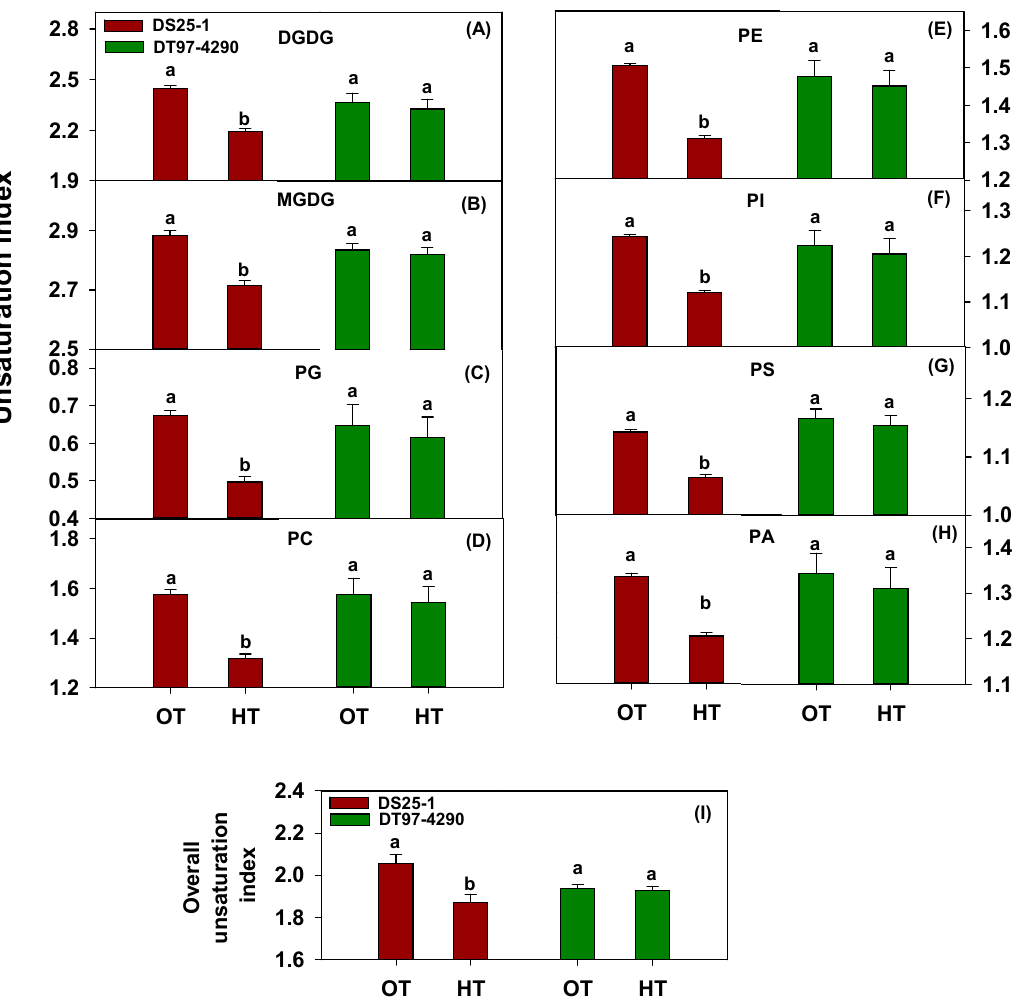
Figure 3. Decrease in unsaturation index under heat stress in the heat-tolerant soybean genotype DS25-1 and no change in unsaturation index under heat stress in the heat-susceptible genotype DT97-4290. Panels A through H show the e ff ects of temperature on unsaturation index of various lipid head group classes (DGDG, MGDG, PG, PC, PE, PI, PS, and PA). Panel I shows the e ff ect of temperature on overall unsaturation index. The unsaturation index of each lipid molecular species was calculated as the average number of double bonds per acyl chain, which is the number of double bonds in the lipid molecular species divided by the number of acyl chains. The unsaturation index of a lipid head group class was calculated as the [sum of (the unsaturation indices of individual lipid molecular species in that class times the amount of each species)] divided by the sum of the amount of lipid molecular species in the class. Values shown are least squares means ± SE. Least squares means with di ff erent letters are significantly di ff erent according to the least significant di ff erence (LSD) test at α = 0.05. Comparisons have been done between temperature treatments within each genotype. OT, optimal temperature (30 / 20 ◦ C). HT, high temperature (38 / 28 ◦ C). DGDG, digalactosyldiacylglycerol. MGDG, monogalactosyldiacylglycerol. PG, phosphatidylglycerol. PC, phosphatidylcholine.